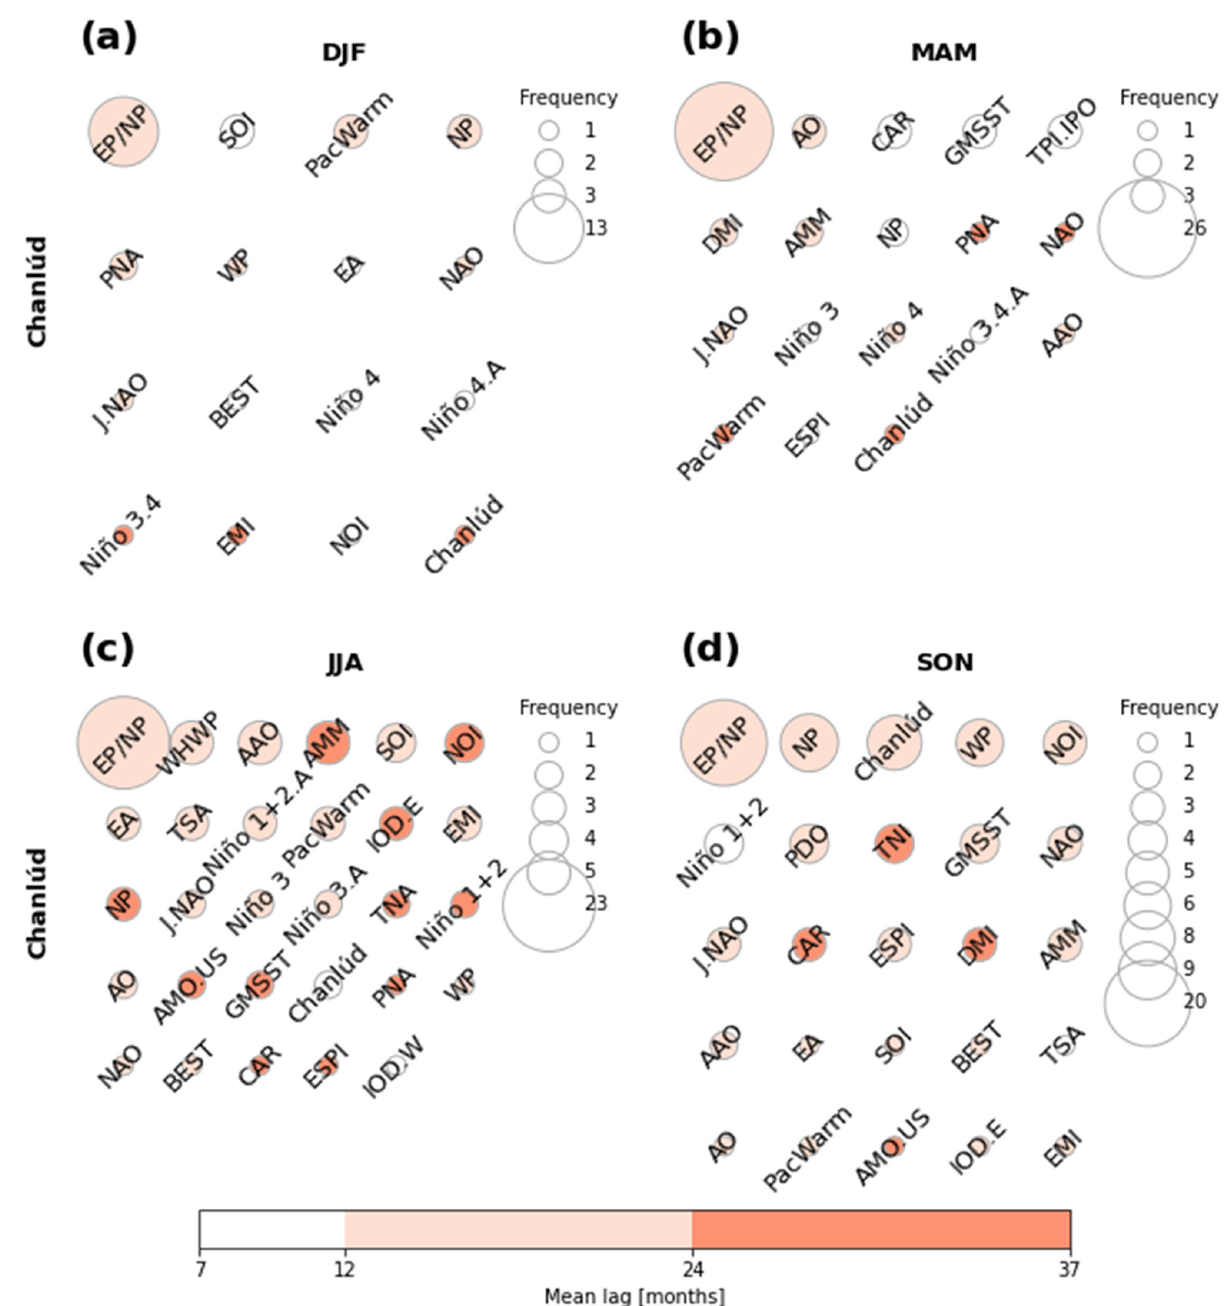
Figure 6. Predictors selected through SFS for each quarterly model for Chanlúd (dots in Figure 4d): ( a ) quarter December–February; ( b ) quarter March–May; ( c ) quarter June–August; ( d ) quarter September–November. The size of each circle corresponds to the frequency with which a climate index (with different lags) appears as a predictor of the model. The color of each circle corresponds to the mean of the lags with which a climate index appears as a predictor of the model.